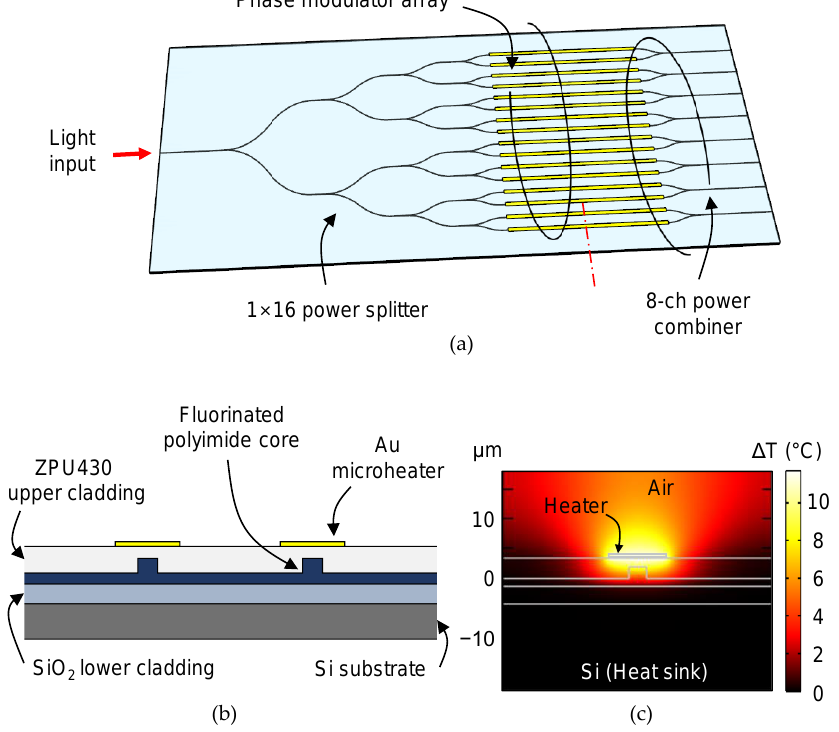
Figure 1. ( a ) Schematic of the polyimide waveguide thermo-optic phase modulator (TOPM) array which can be applied to an optical phased array (OPA) device. The TOPM array consists of a 1 × 16 beam splitter and 16 phase modulators (PM), and each of the two channels of the phase modulators is combined to form 8 Mach – Zehnder interferometers (MZI). ( b ) Cross-section of a MZI showing two cores of rib waveguides and microheaters on top of the upper cladding. ( c ) The heat distribution that occurs across the waveguide cross-section when the microheater is heated.